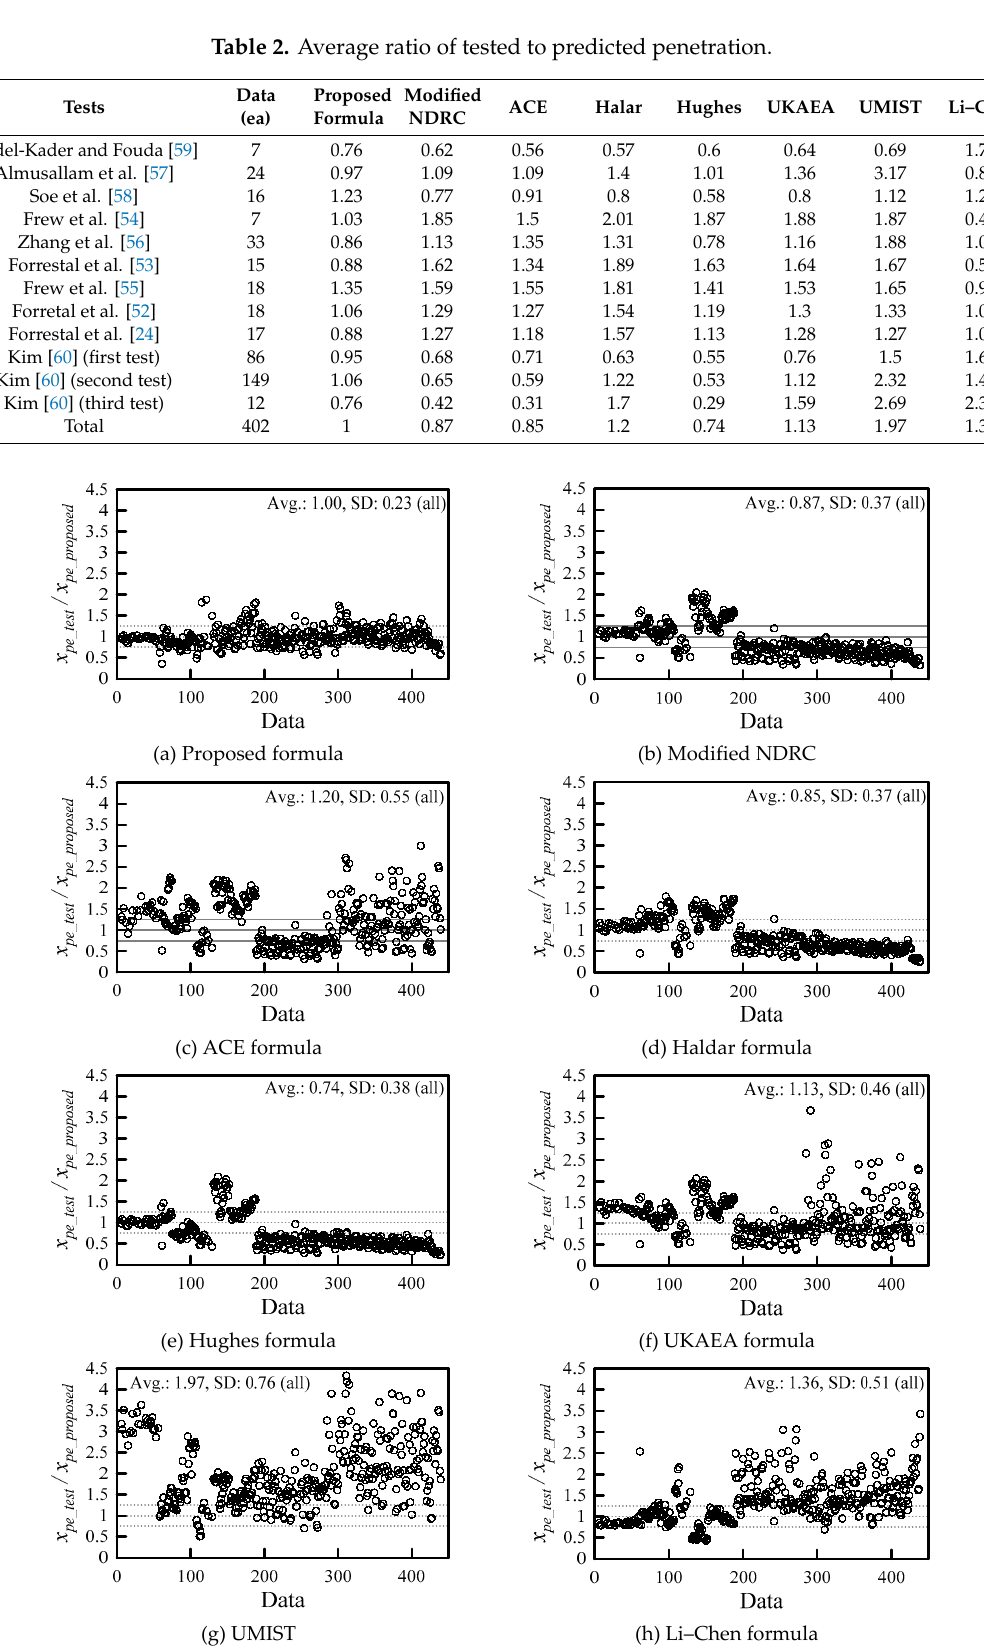
Figure 10. Ratio of tested to predicted penetration depth (Avg. is the average and SD is the standard deviation).